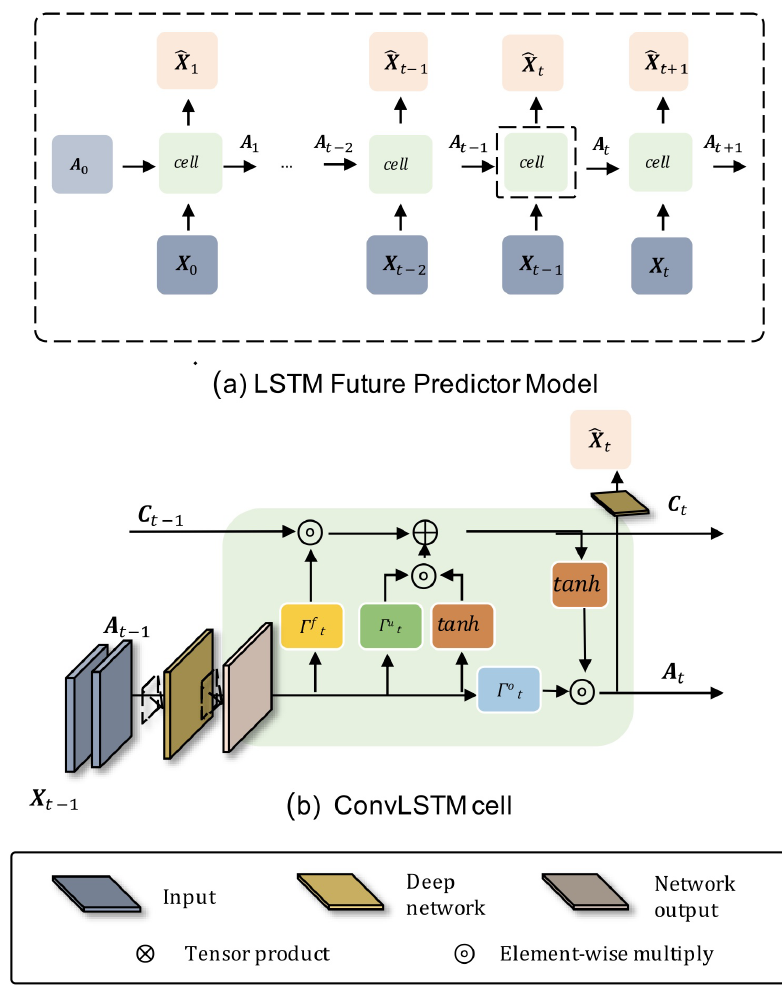
Figure 3. Sketch of ConvLSTM architecture (based on arguments in Xingjian et al., 2015).